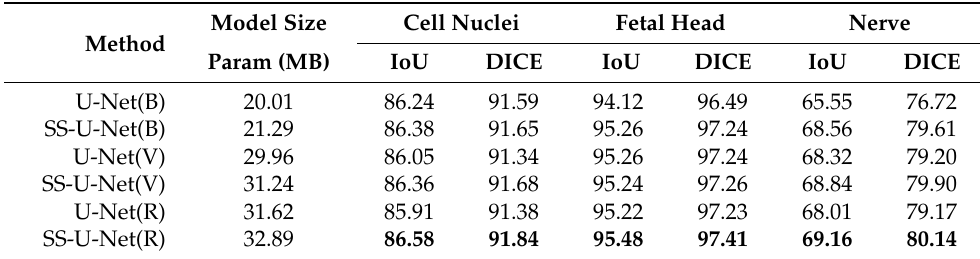
Table 2. Performance comparison for image segmentation using various convolution blocks with the SS scheme. The “B”, “V”, “R”, and “SS” represent the Bottleneck structure, VGG blocks, Residual block, and Self-Spatial normalization, respectively. Intersection over union (IoU) and the Dice coefficient are used in terms of comparison metrics (%). Numbers in bold indicate the highest performance in each